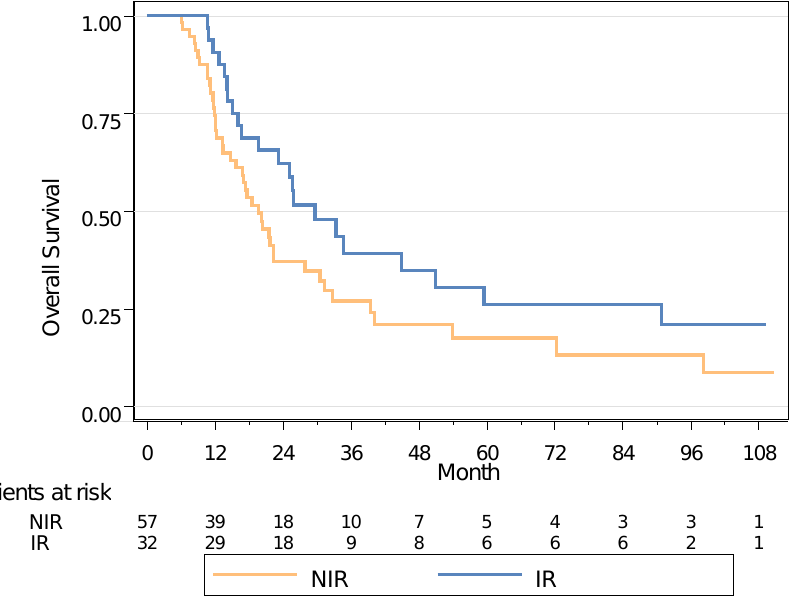
Figure 3. Overall survival in landmark analysis at 6 months for NIR (no irradiation) vs. IR group (radiotherapy within 6 months).